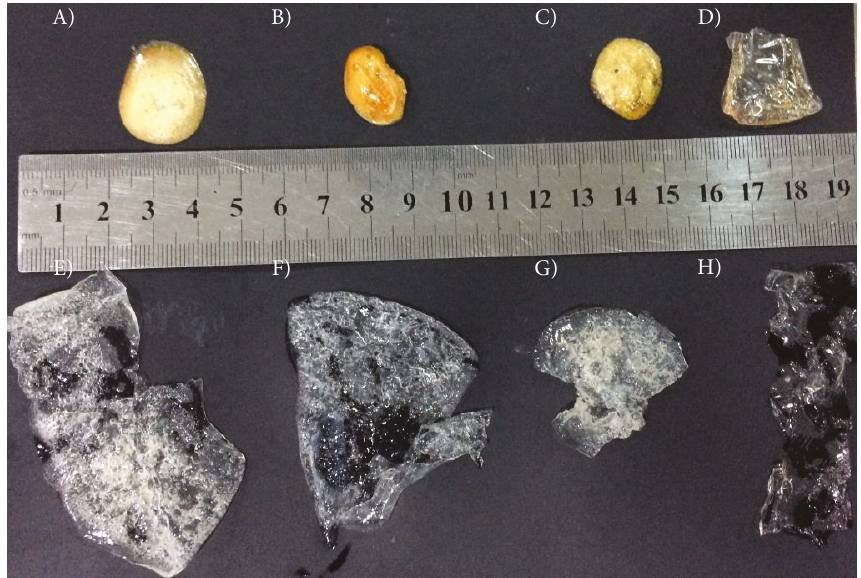
Figure 7: Swelling studies on xerogels. The samples in this fi gure are (A) dried H.6.20 (6% HOP and 20% of gelatin), (B) dried L.6.20 (6% LOP and 20% of gelatin), (C) dried N.6.20 (6% NOP and 20% of gelatin), (D) dried 0.20 solely gelatin (20% gelatin), (E) swelled H.6.20 (6% HOP and 20% of gelatin), (F) swelled L.6.20 (6% LOP and 20% of gelatin), (G) swelled N.6.20 (6% NOP and 20% of gelatin), and (H) swelled 0.20 solely gelatin (20% gelatin).